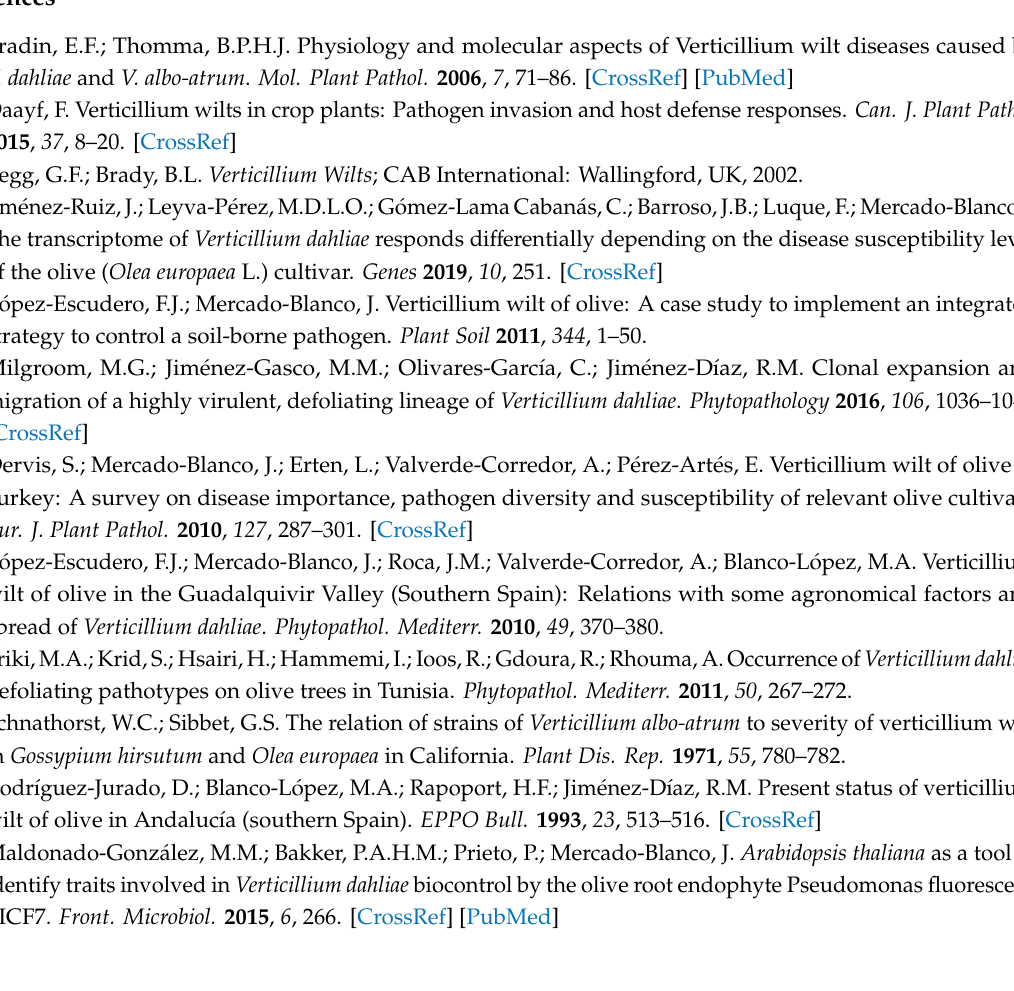
Figure S1: Mapping e ffi ciency of bisulfite treated PE reads with its own genome, Figure S2: GO term analysis of the 831 genes selected, Table S1: List of genes that showed a methylation pattern inversely correlated to the virulence of the isolates, Table S2: ABC and MFS transporters